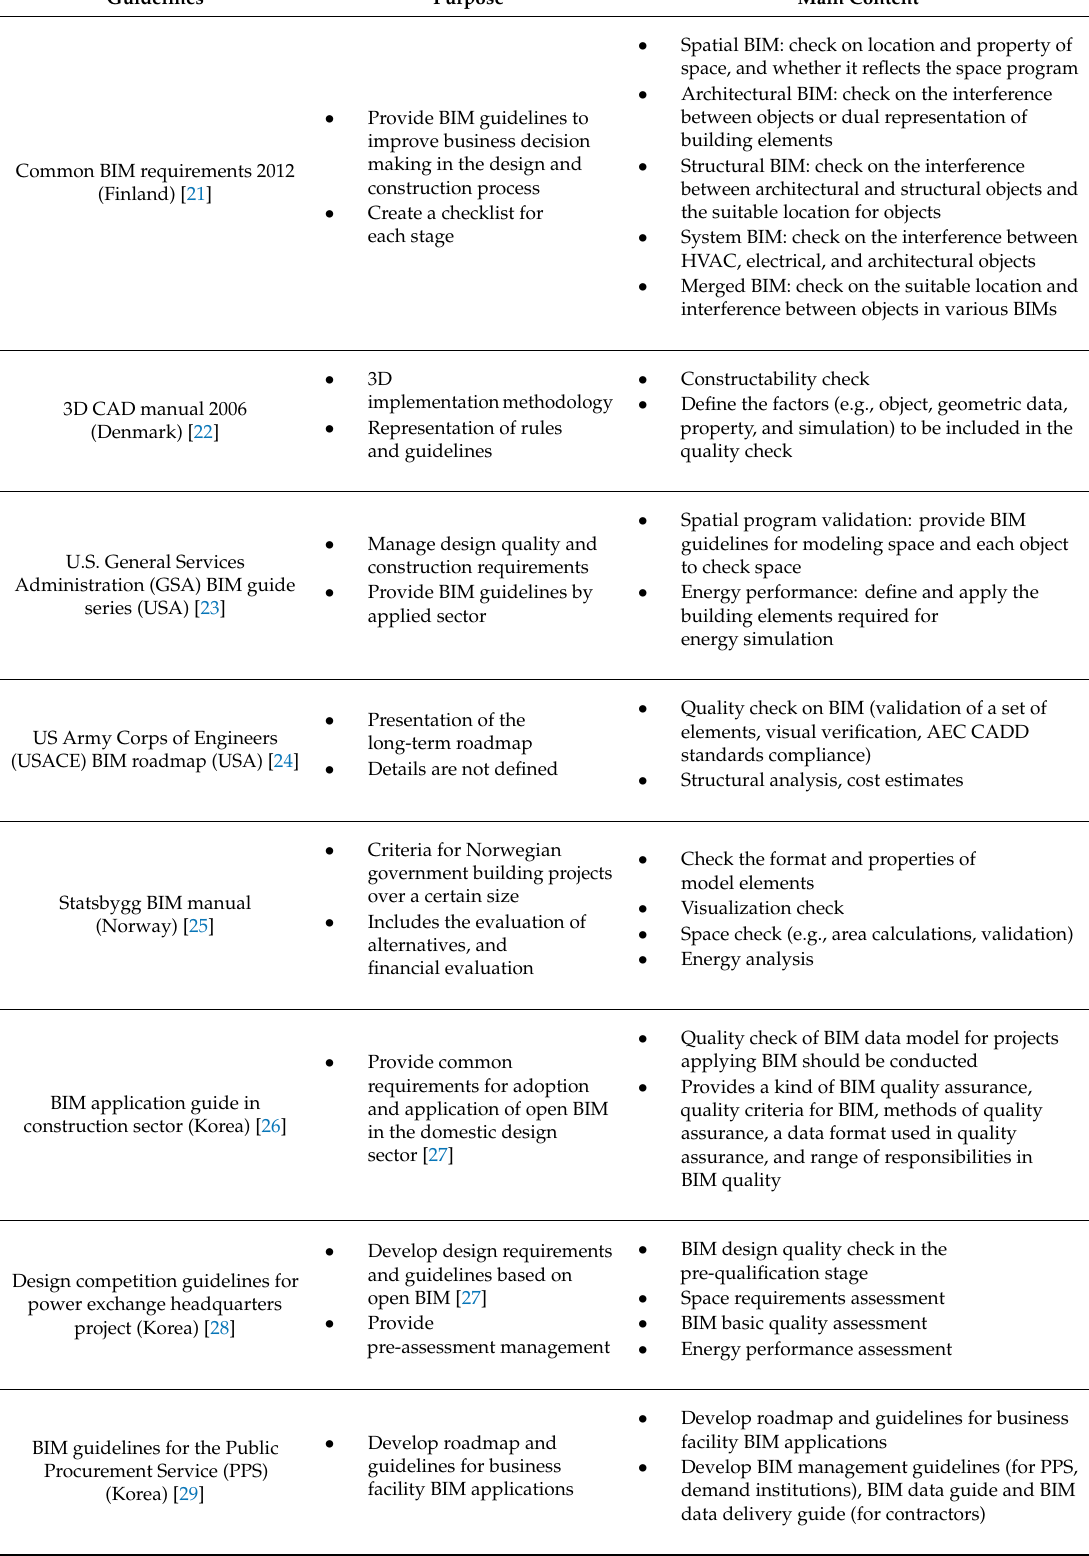
Table 2. The status and content of BIM-based guidelines for quality